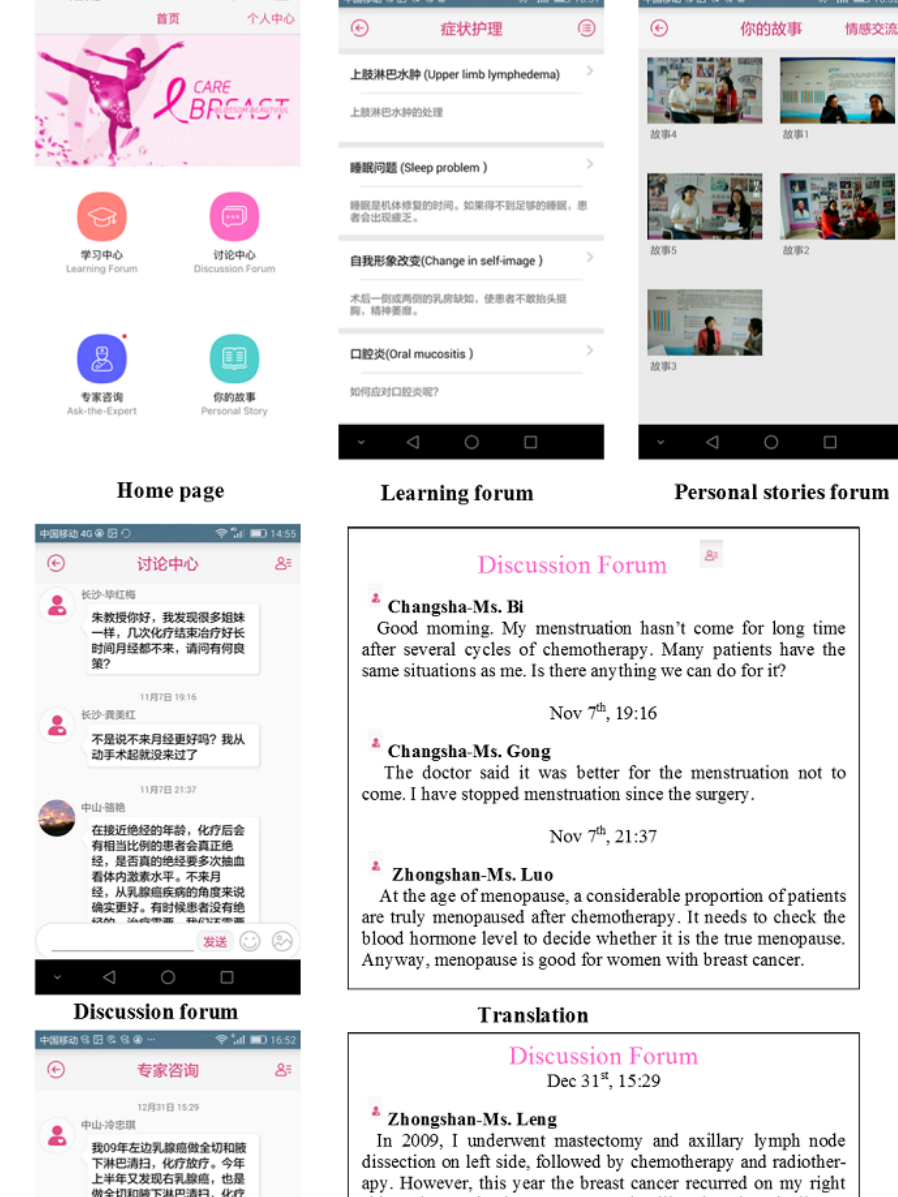
Figure 1. Screenshots of the breast cancer e-support (BCS) program home page and the 4s